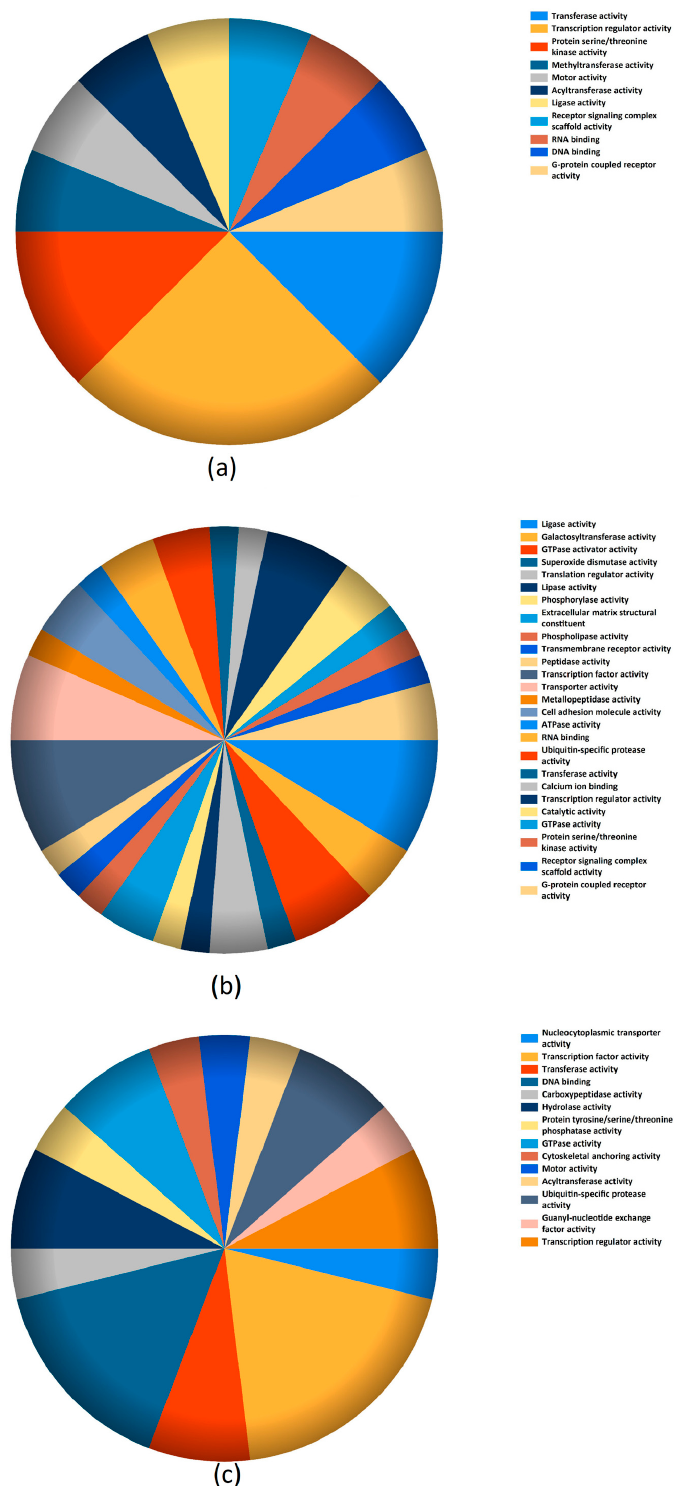
Figure 3. Molecular function of sncRNAs gene targets downregulated at Day 3 vs. Day 2 ( a ), Day 3 vs. Day 5 ( b ), and Day 5 vs. Day 3 ( c